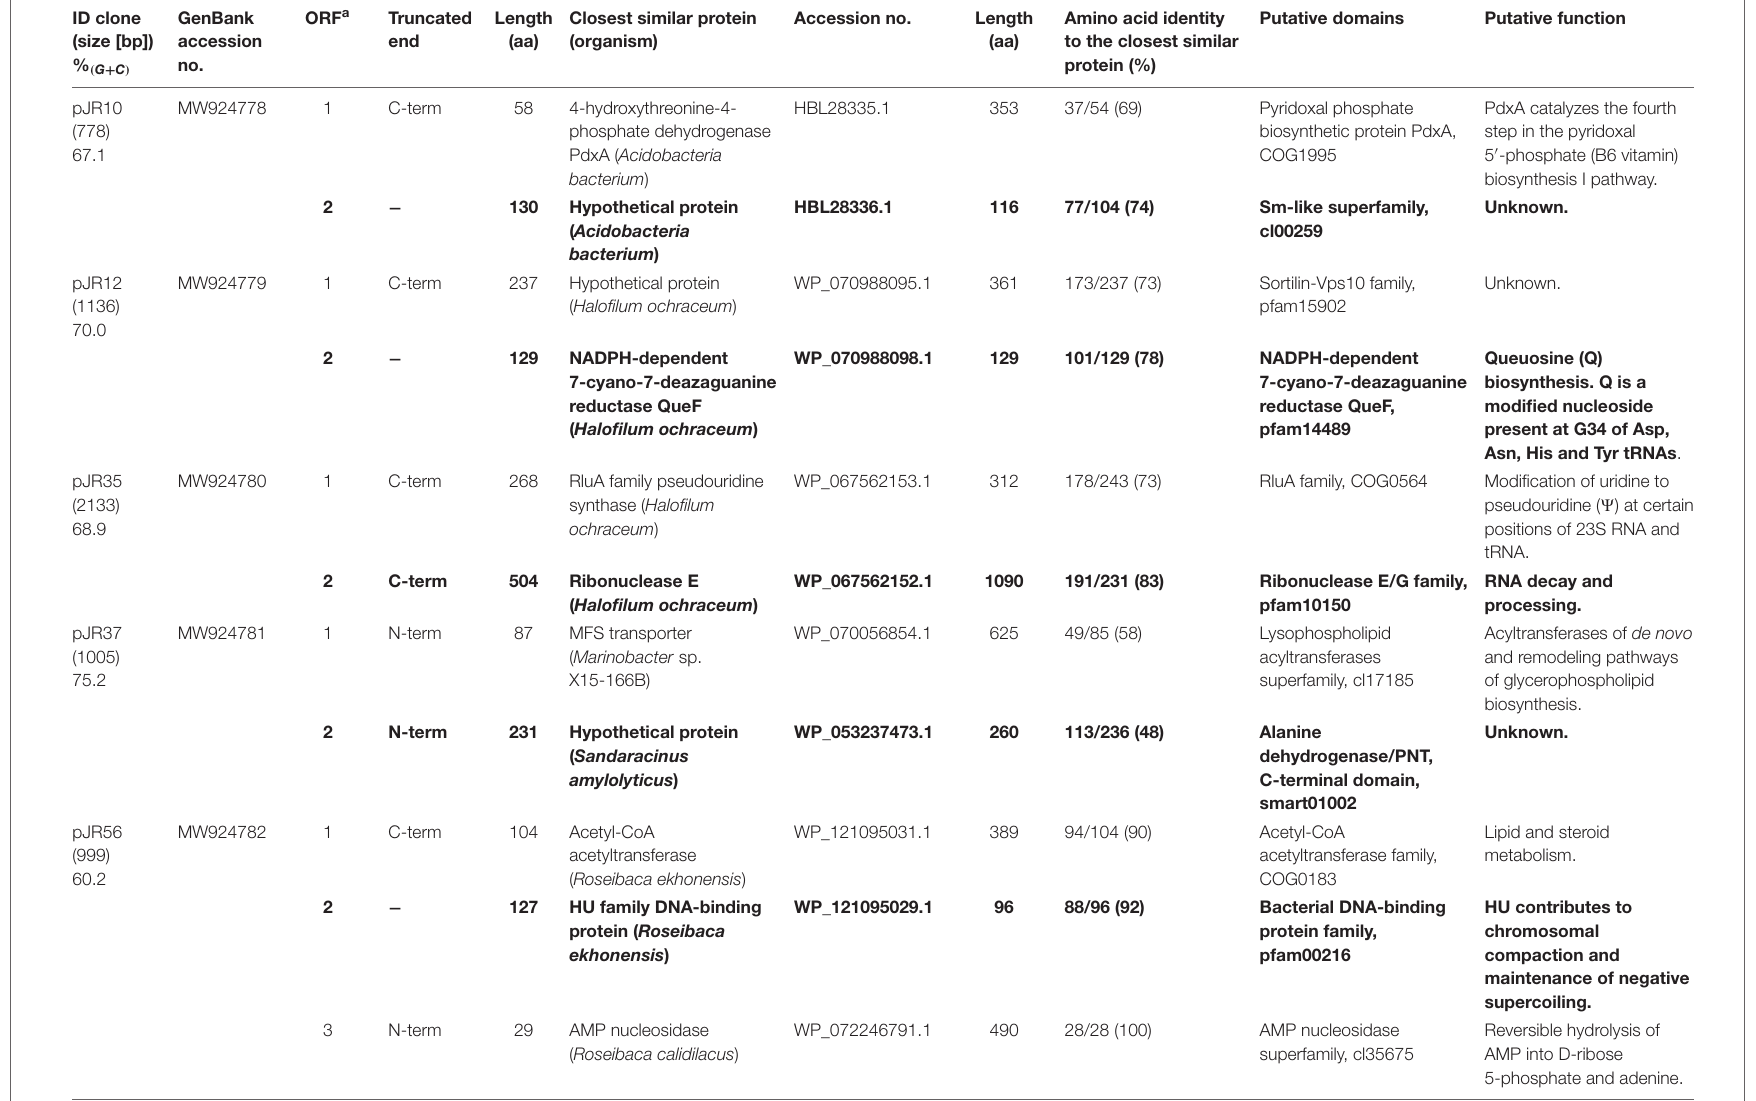
TABLE 1 | Description of the perchlorate-resistant plasmids and their observed sequence similarities. ID clone (size